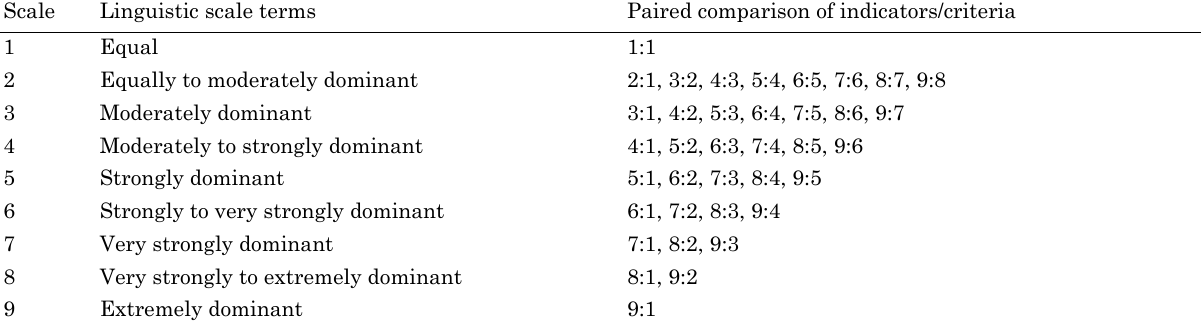
Table 2. Cybernetic scales